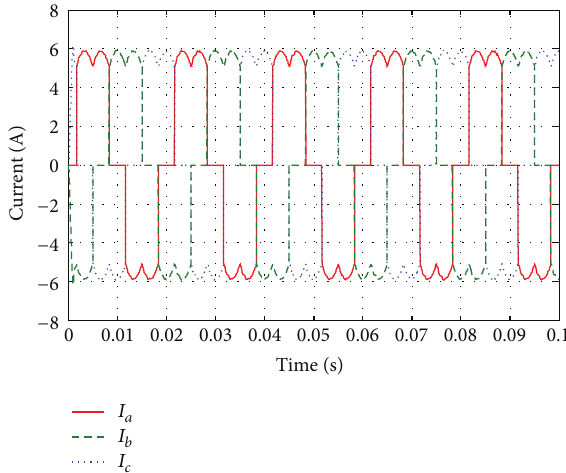
Figure 22: Output current waveforms (i.e., 𝐼 𝑎 , 𝐼 𝑏 , and 𝐼 𝑐 ) of the three-phase inverter with nonlinear load.